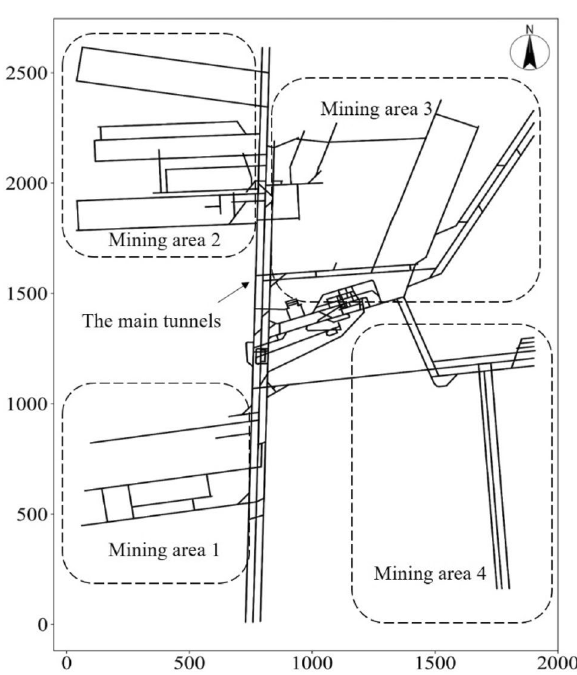
Figure 7. Distribution of mining areas in Beiyangzhuang